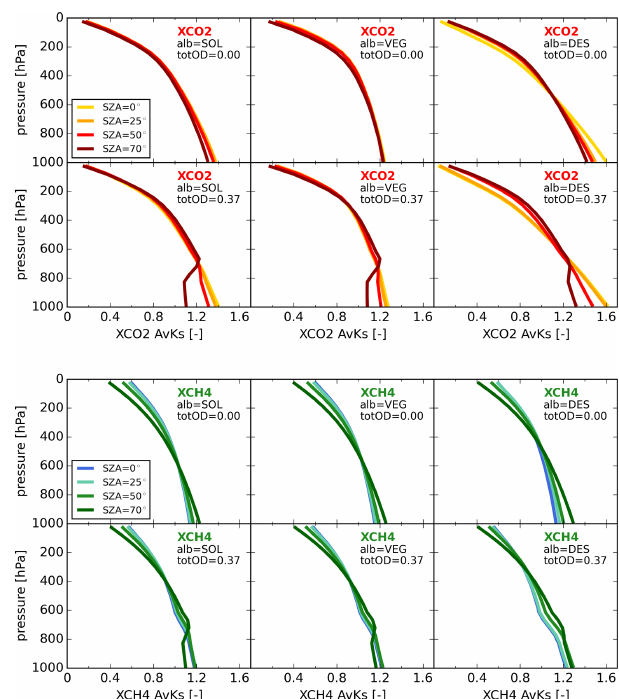
Figure 8. NanoCarb X CO (top panels) and X CH (bottom panels) 2 4 column-averaging kernels averaged over the 23 FOV pixels used to interpolate L2 results to the whole FOV. We show all three albedo models, soil (left), vegetation (middle), and desert (right), and four different SZA values (colour scales). Averaging kernels are shown for a low total aerosol optical depth (top rows) and a high total aerosol optical depth (bottom